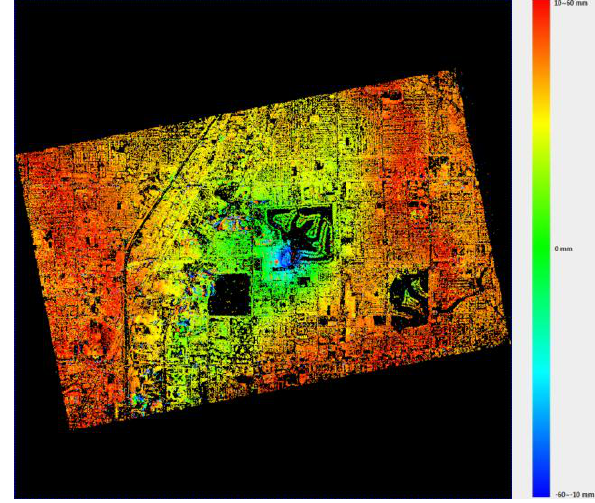
Figure 6. An overview of PS-InAR point clouds of Las Vegas ascending stack Our web-based interactive visualization is not static, but dynamic. It allows zooming, shifting, and rotating to observe all details. In Figure 7, the Las Vegas Convention Center is shown. (4) The building is a large structure consisting of several simple and regular shapes. The building deformation is shown in different colours.